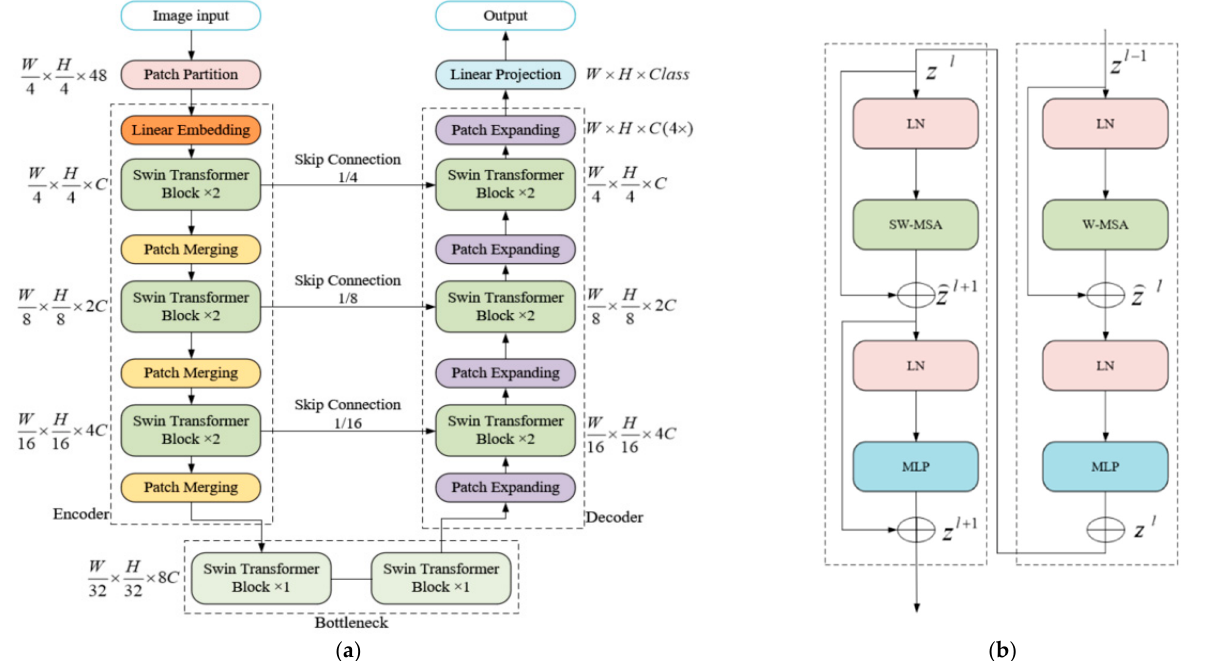
Figure 3. The network structure of the import method: ( a ) Network Structure of Swin-Unet; ( b ) Structure diagram of the Swin Transformer block.